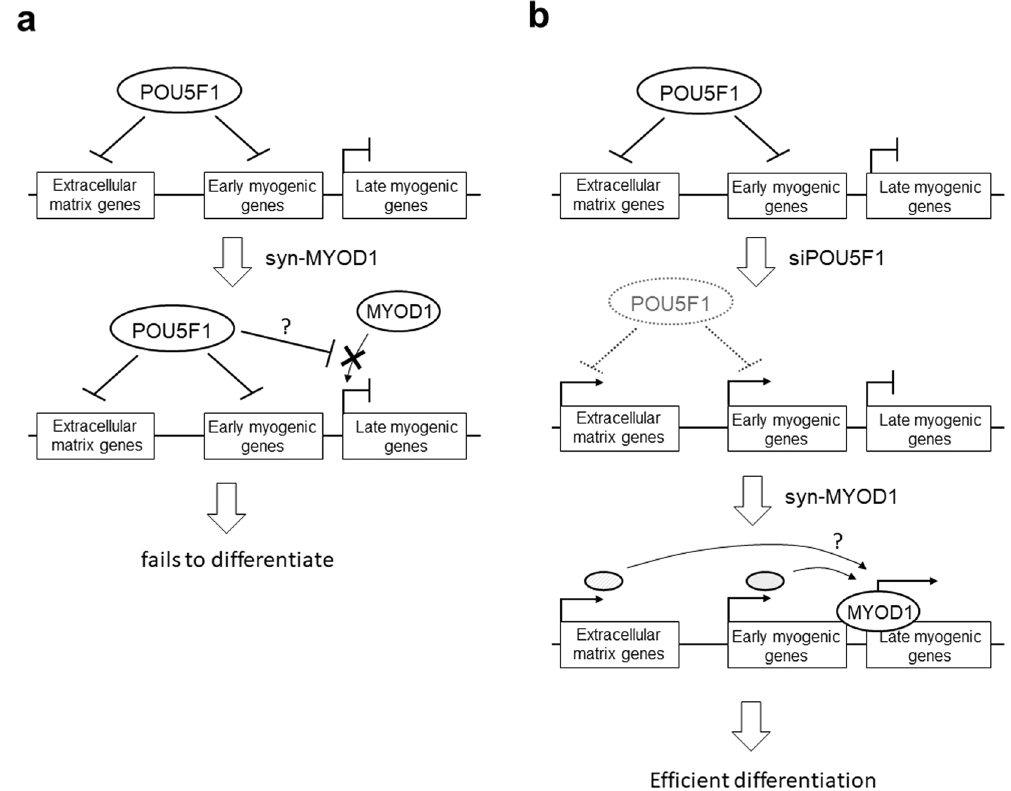
Figure 6. A model of the mechanism for the effective myogenic differentiation of hPSCs with siPOU5F1 and synMYOD1. ( a ) In hPSCs, POU5F1 directly represses the expression of the genes related to extracellular matrix and early myogenic genes such as PAX3 and PAX7. Additionally, when synMYOD1 alone is introduced in hPSCs, POU5F1 inhibits the access of the translated MYOD1 protein to the target late myogenic genes such as MEF2C and MYOG, which results in the failure of myogenic differentiation. ( b ) Knockdown of POU5F1 with siPOU5F1 causes the activation of extracellular matrix genes and early myogenic genes. Consequently, when synMYOD1 is introduced, the translated MYOD1 protein can access to the promoters of the late myogenic genes to activate terminal myogenic gene activation. These mechanisms facilitate the rapid and highly efficient myogenic differentiation in